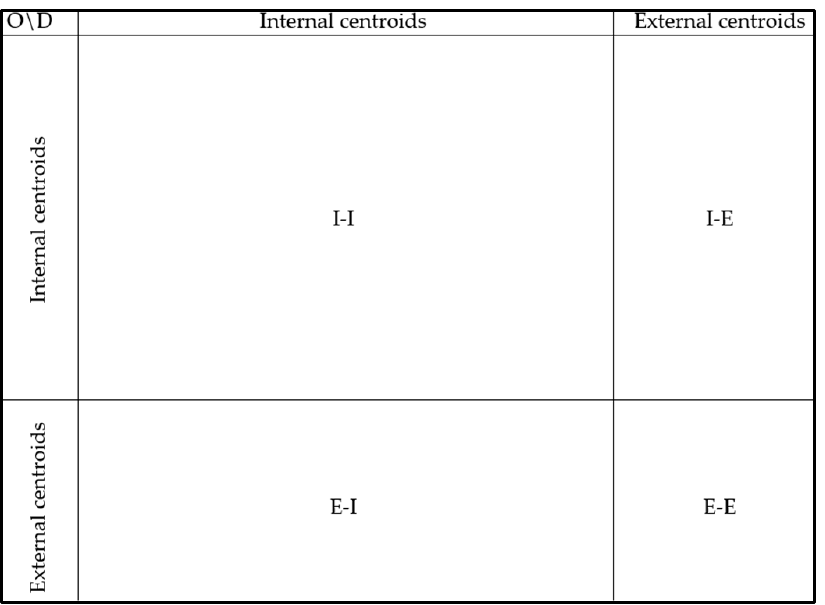
Figure 10. OD matrix scheme.